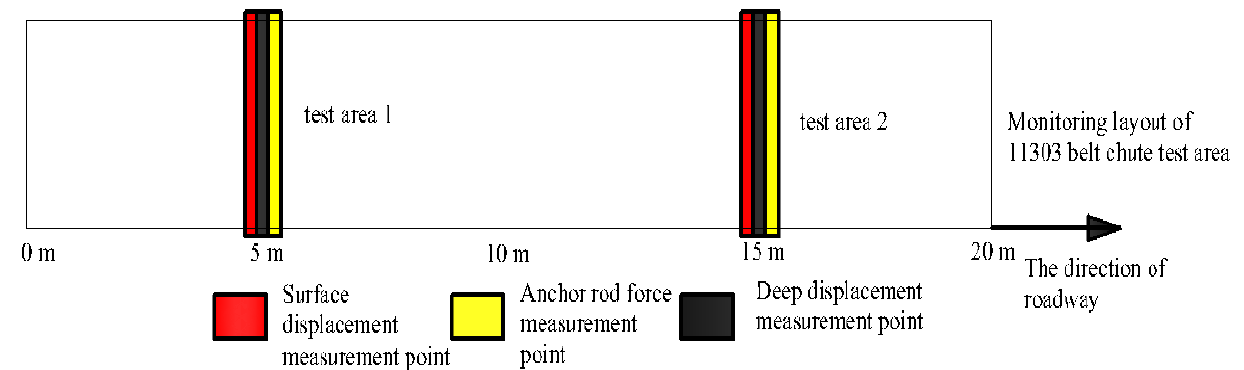
Figure 17. Monitoring layout of 11303 belt chute test area.